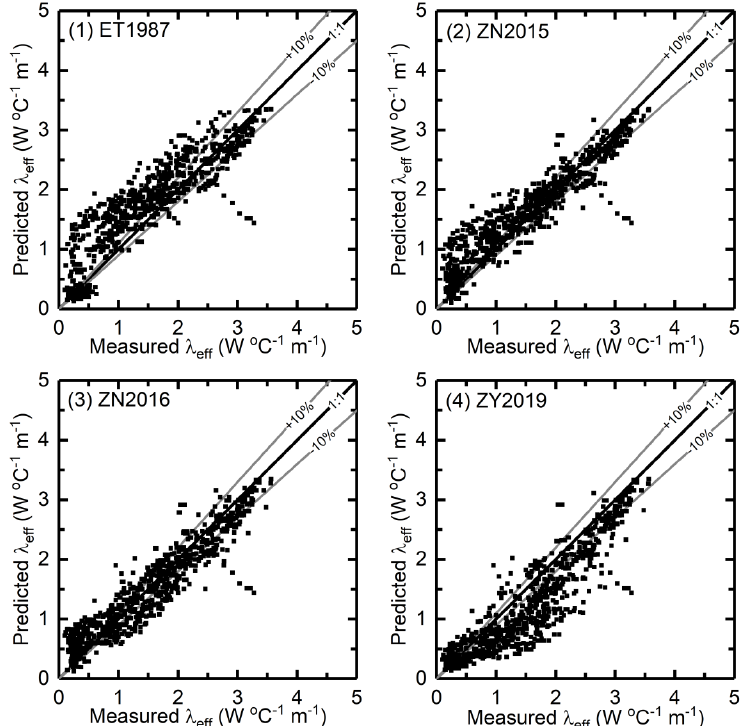
Figure 2. Comparison of measured λ eff and predicted λ eff with four normalized thermal conductivity models: ( 1 ) ET1987 [23], ( 2 ) ZN2015 [24], ( 3 ) ZN2016 [25] and ( 4 ) ZY2019 [26].